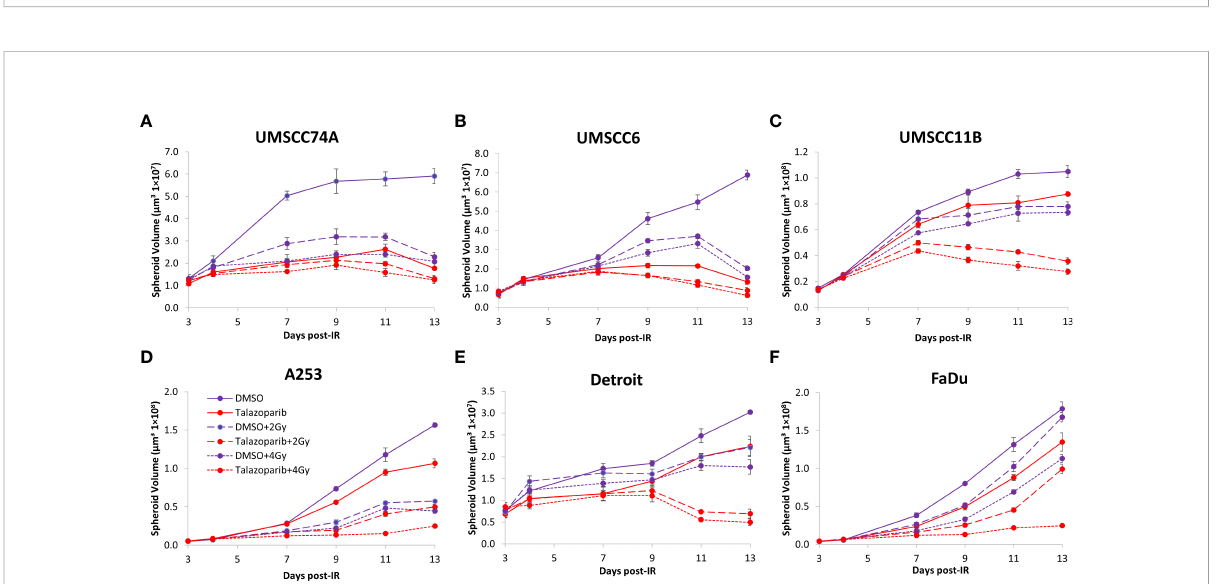
FIGURE 9 Impact of talazoparib on the radiosensitivity and growth of HPV-negative HNSCC spheroids in response to protons. Spheroids were allowed to develop for 24 h in ultra-low-attachment plates, treated with DMSO or talazoparib (0.1 µM) for a further 24 h, and then unirradiated or irradiated (1 or 2 Gy) on day 3 with a single dose of protons. Growth of spheroids derived from cells from (A, B) the oropharynx (UMSCC74A and UMSCC6), (C) the larynx (UMSCC11B), (D) the salivary gland (A253), and (E, F) the hypopharynx (Detroit 562 and FaDu) was measured by microscopy up to 13 days post-seeding and analysed from three biologically independent